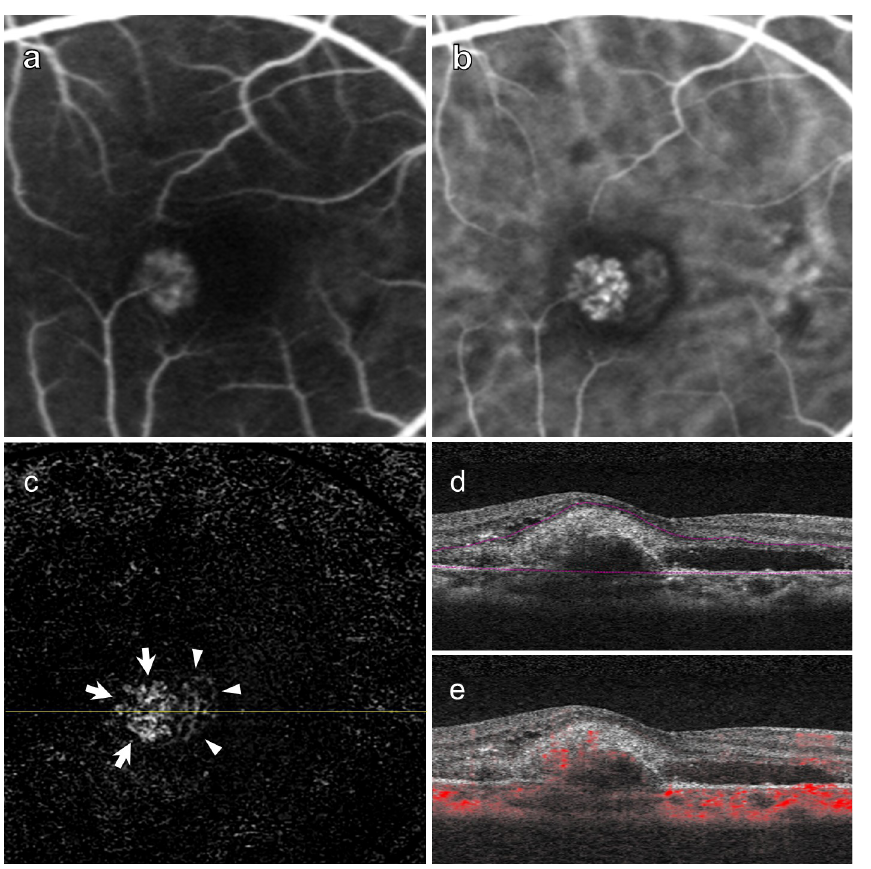
Fig 3. A case of Type 2 choroidal neovascularization (CNV). Right eye images of a 66-year-old woman with a visual acuity of 20/32. (a) Early-phase fluorescein angiography showing neovascular vessels that indicates a predominantly classic CNV. (b) Indocyanine green angiography showing the entire CNV. (c) 3 × 3-mm en face optical coherence tomography angiography (OCTA) images after removal of projection artifacts showing the dense small vessels. Note that the area corresponding with type 2 CNV (arrows) seems more vessel-dense compared to the area corresponding with type 1 CNV (arrow heads). (d) Corresponding B-scan images showing the segmentation lines. (e) Corresponding B-scan images with flow signals. Note the abnormal signals above and beneath the RPE, indicating that the lesion contains both type 1 and type 2 CNVs.